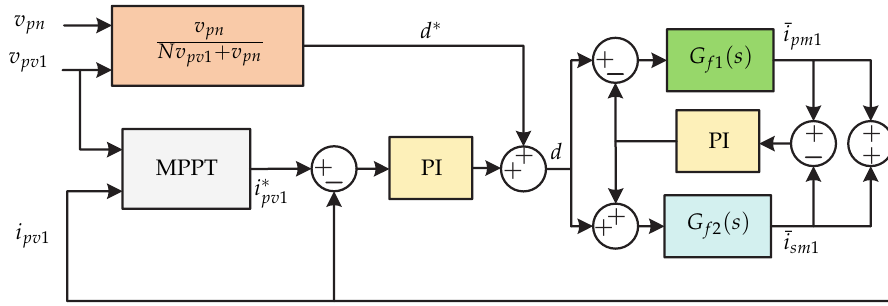
Figure 31. Control strategy of the MPPT proposed in [66].